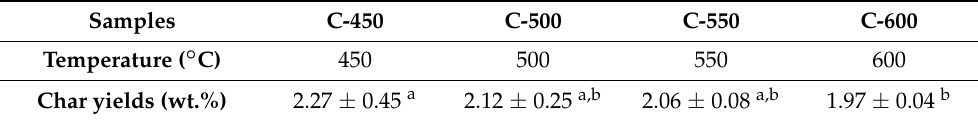
Table 3. Char yields